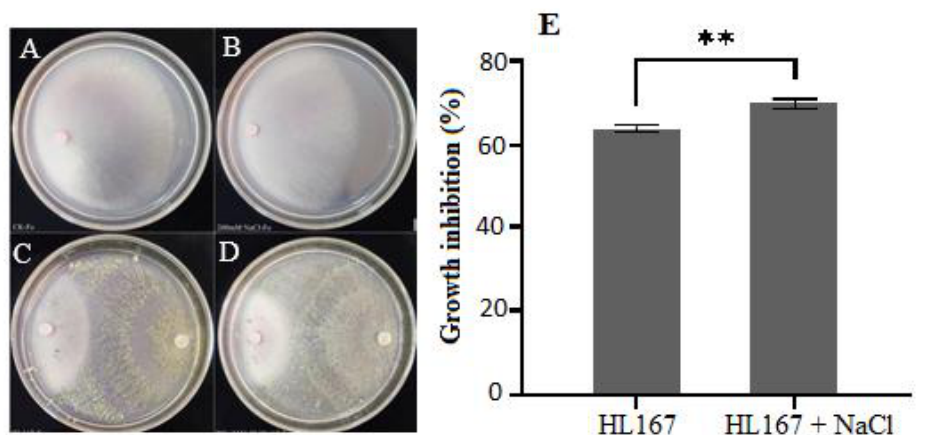
Figure 5. Inhibitory effects of T. longibrachiatum HL167 and 200 mM NaCl on the growth of F. oxysporum . ( A , B ) Morphological characterization of F. oxysporum . ( A ) control: Potato dextrose agar (PDA) without 200 mM NaCl, ( B ) PDA with 200 mM NaCl. ( C , D ) Morphological characterization of F. oxysporum in dual culture. ( C ) PDA without 200 mM NaCl, ( D ) PDA with 200 mM NaCl. ( E ) Growth inhibition (%) of F. oxysporum in dual culture, “**” p = 0.0015 ( n = 3).